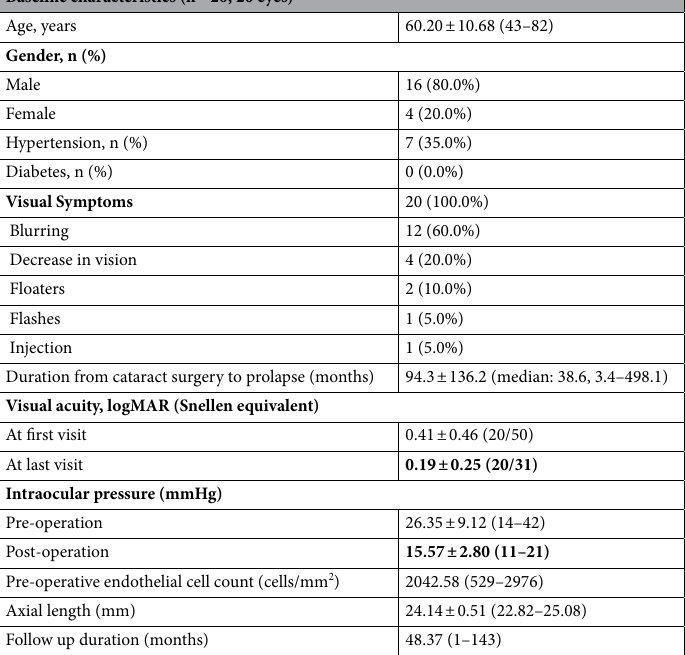
Table 1. Baseline characteristics for patients with delayed vitreous prolapse. Age, visual acuity, and intraocular pressure displayed as mean ± SD. N displayed as number (%). Follow-up duration = post-operative follow-up period after surgical intervention for the prolapse. FC = 2.00 logMAR, HM = 2.30 logMAR, LP = 2.60 logMAR, no light perception = 2.90 logMAR. logMAR logarithm of the minimal angle of resolution.